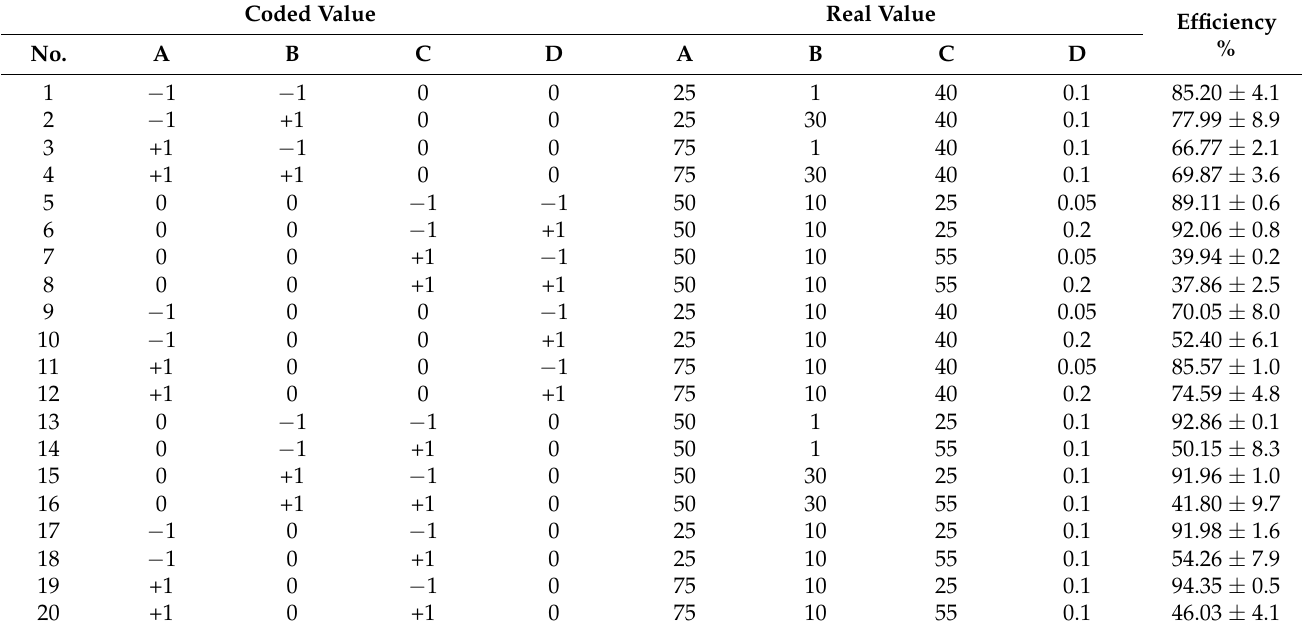
Table 3. Efficiency results of the 27 experiments according to the BBD matrix, including the coded and real values (compare Table